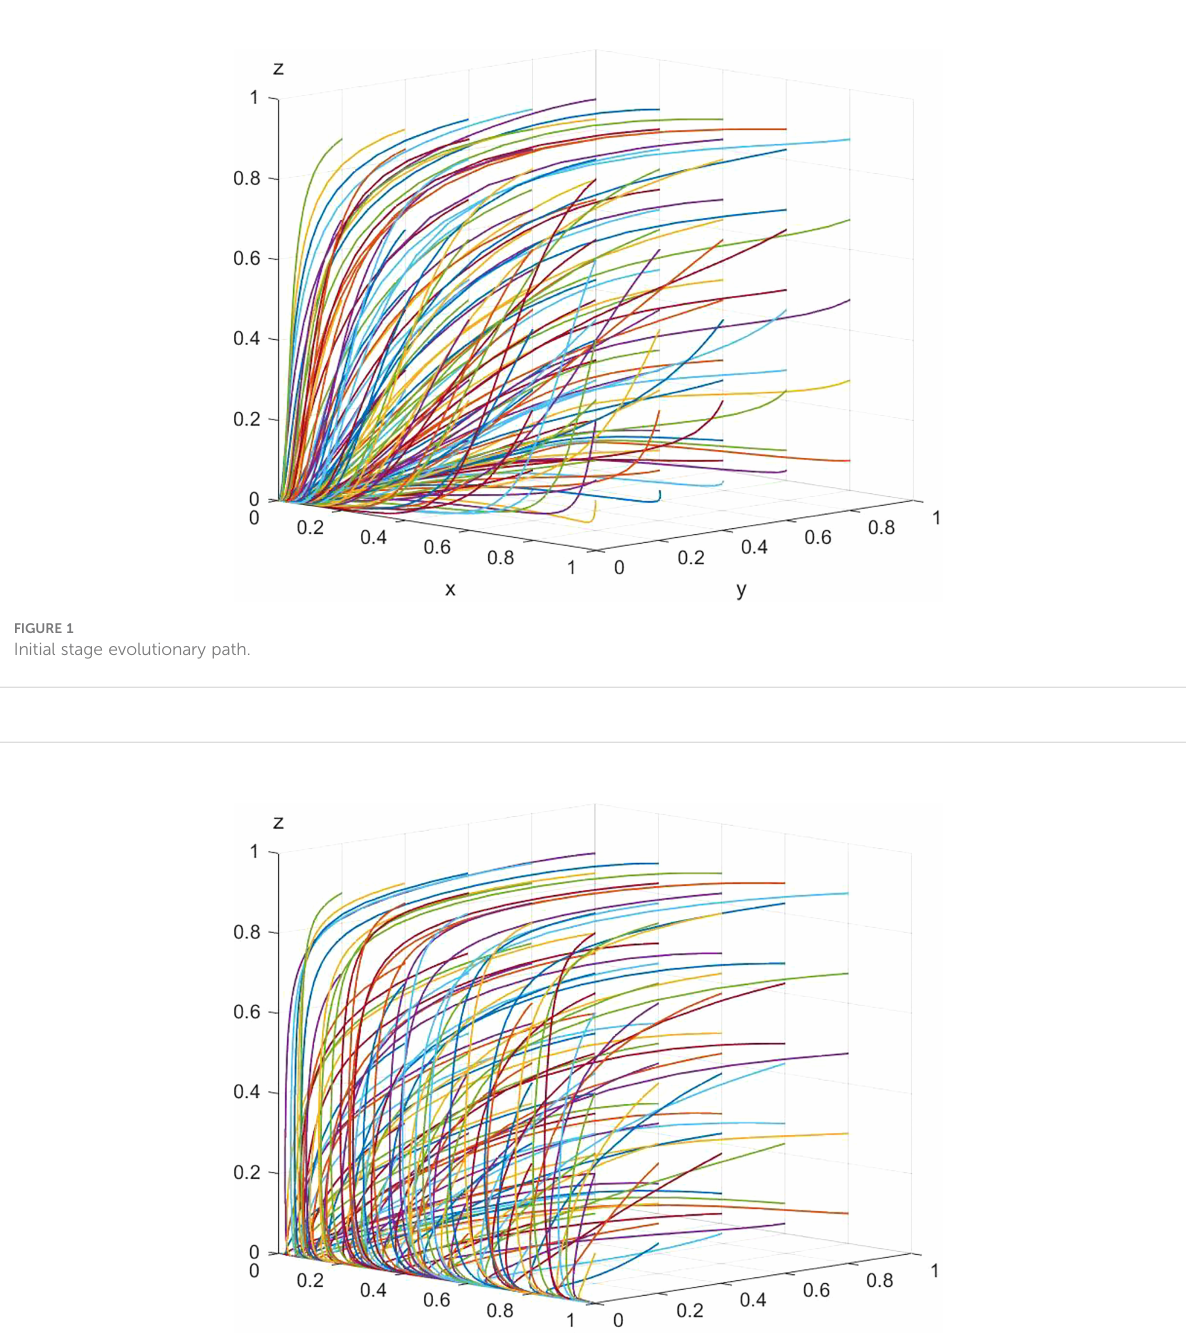
FIGURE 2 Development stage evolutionary